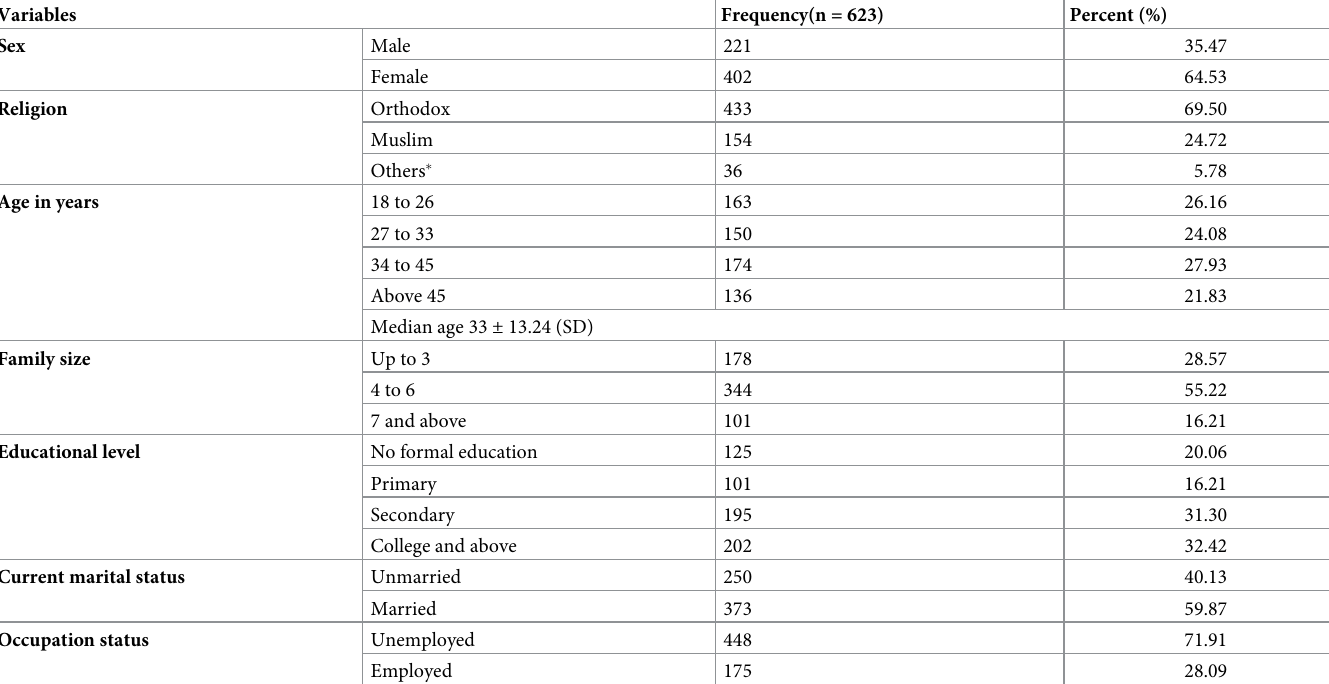
Table 1. Socio-demographic characteristics of the study participants in Gondar city, northwest Ethiopia, 2020. Variables